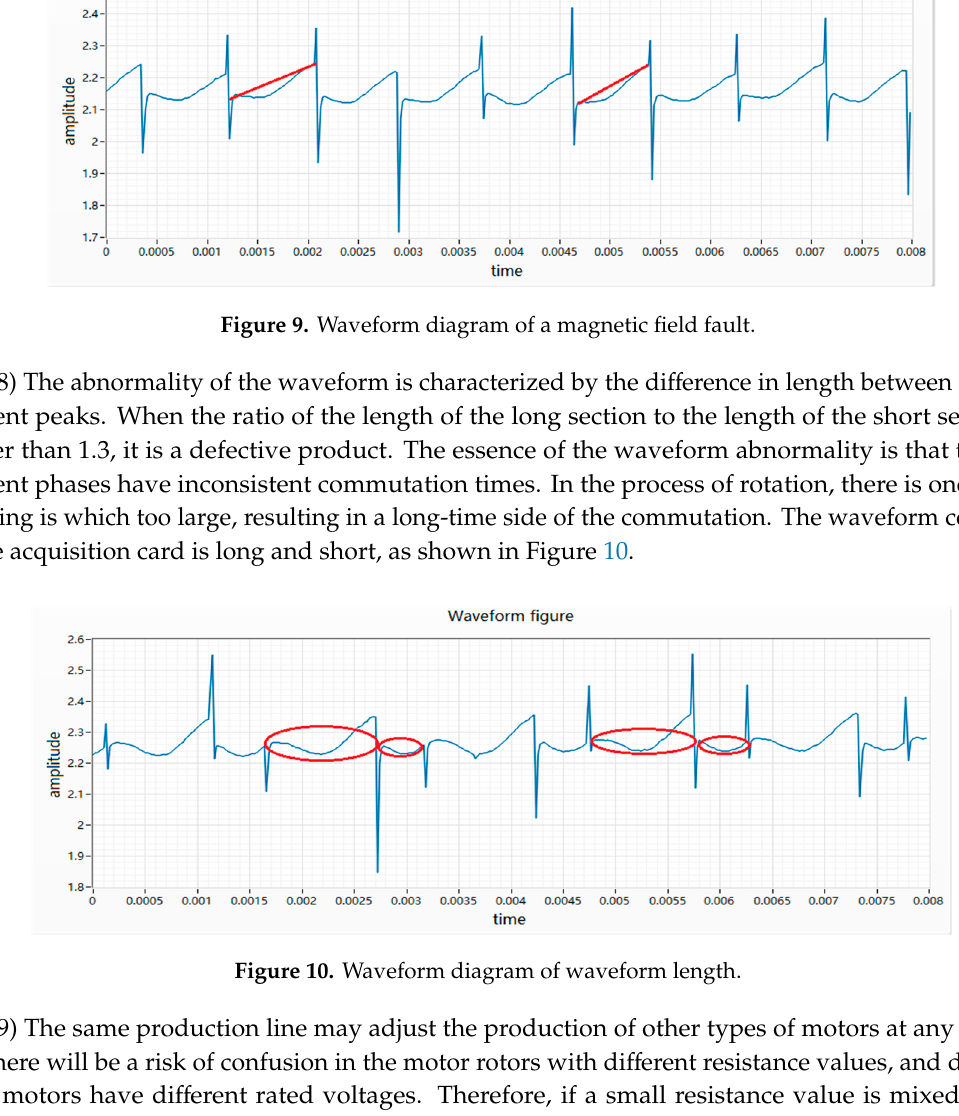
Figure 8. Waveform diagram of wave height.